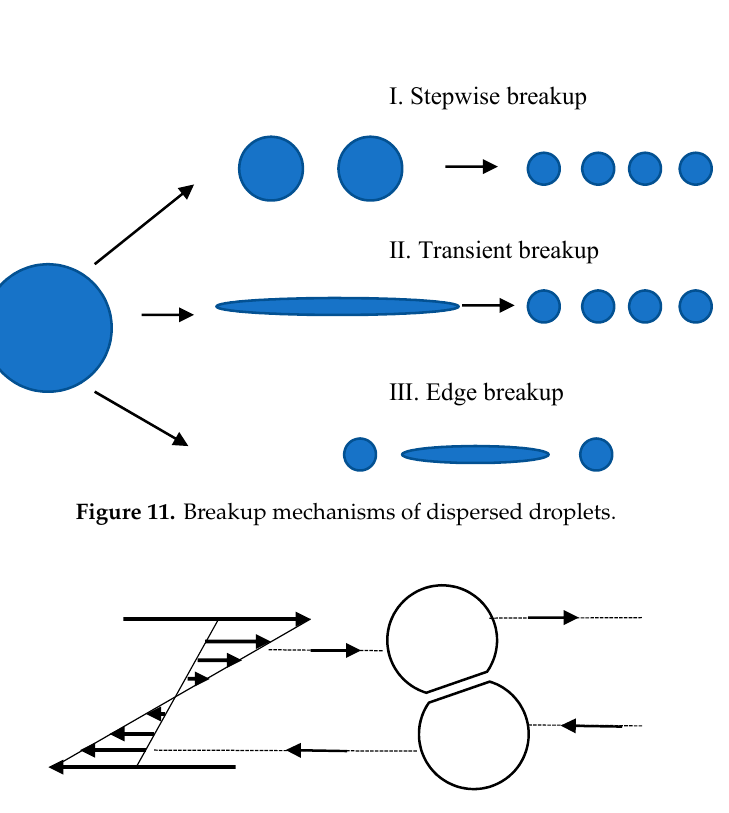
Figure 12. Collision of two droplets in simple shear flow with drainage of the film in between.